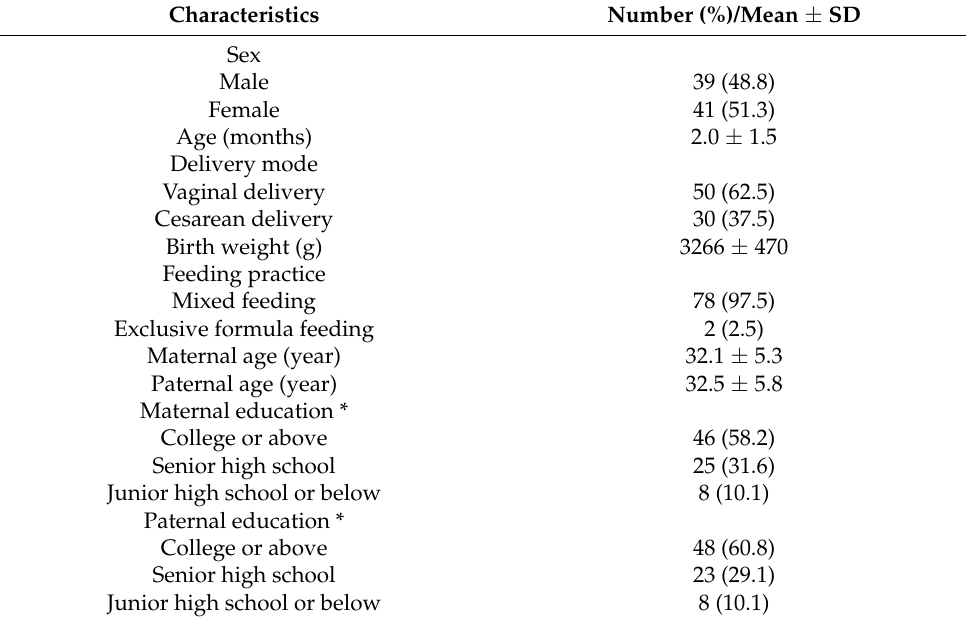
Table 1. Baseline characteristics ( n =